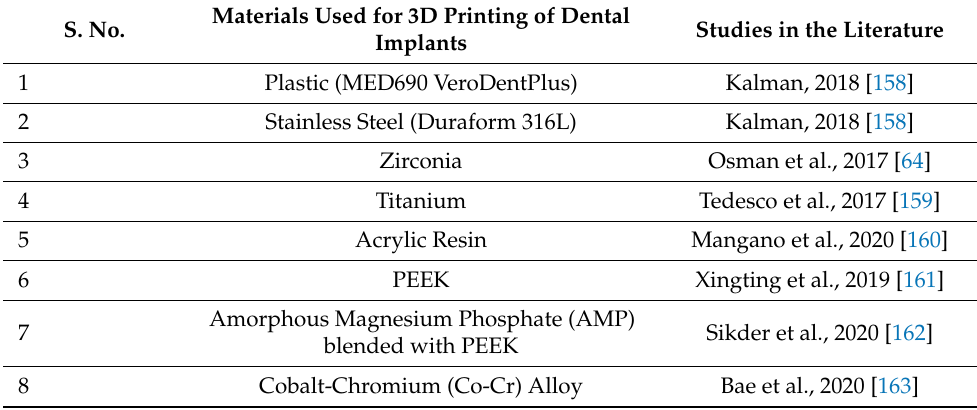
Table 4. Summary of materials used in 3D-printed dental